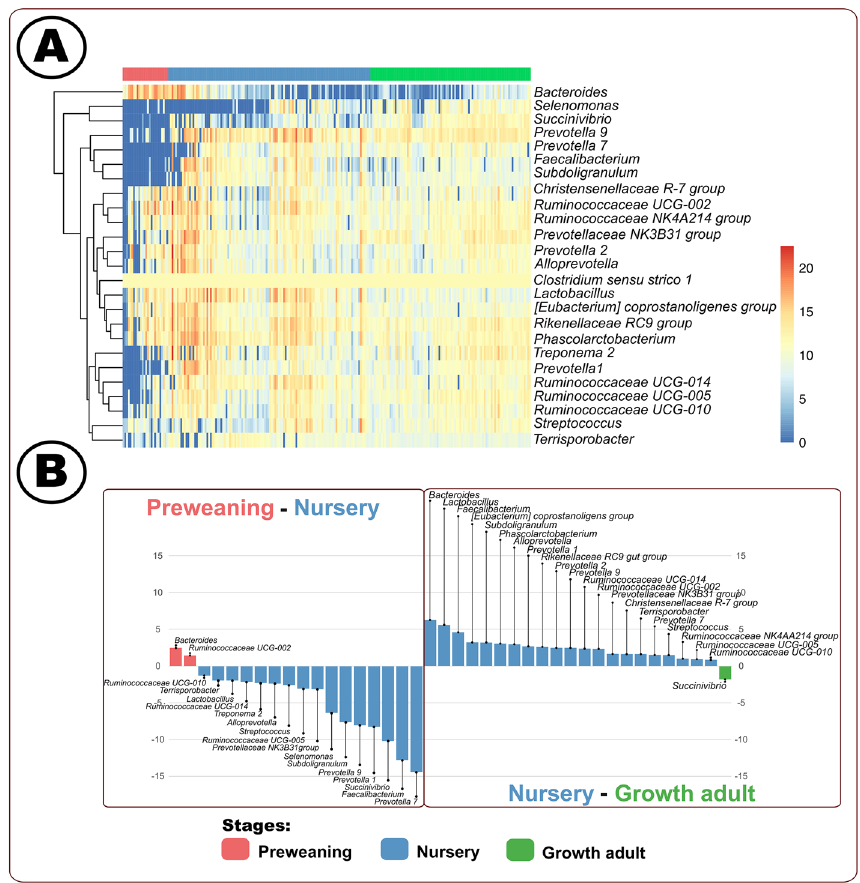
version 1.0.2 (https:// inksc ape. org/) 88